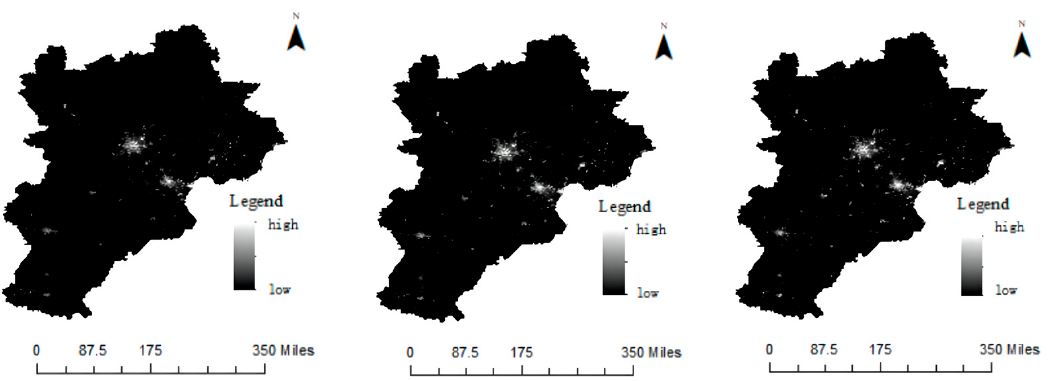
Figure 10. Night-light remote sensing images of Beijing–Tianjin–Hebei region (from left to right: 2013, 2015, 2017).